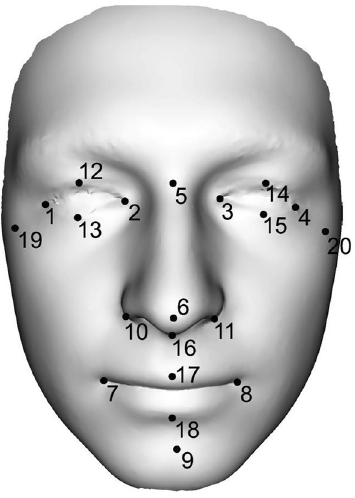
Figure 1. Representation of 20 landmarks on the 3D facial scan. The following dimensions were measured between the individual landmarks: ocular width (1–2, 3–4), ocular height (12–13,14–15), intercanthal width (2–3), biocular width (1–4), distances between exocanthion–nasion (1–5, 4–5), nasal length (5–6), nasal width (10–11), nasal depth (6–16), philtrum height (16–17), nasal height (5–16), dimension between pronasale– pogonion (6–9), mouth width (7–8), mouth height (17–18), facial height (5–9), lower face height (9–16) and facial width